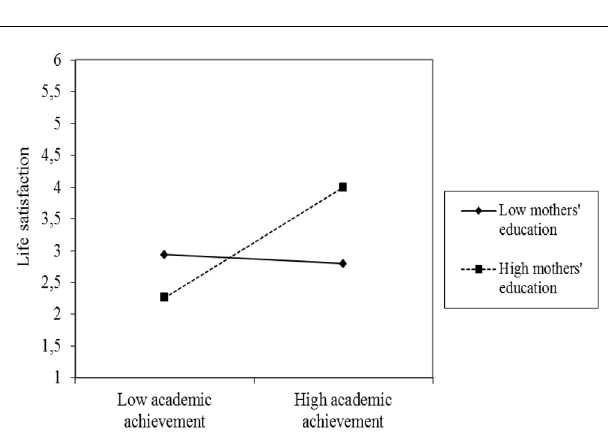
Whilst fathers’ education did not moderate the association betweenstudents’LSscoresandacademicachievement( t =− 0.29,